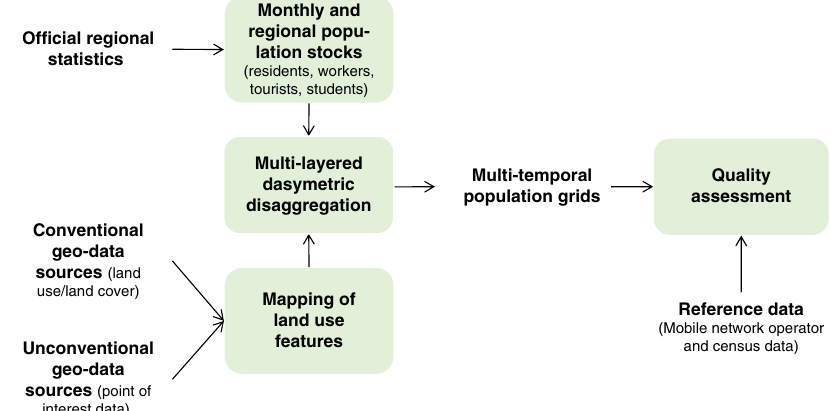
Fig. 5 Methodological work fl ow. Representation of the main classes of input data and methodological steps (green boxes) carried to produce and validate the multi-temporal population